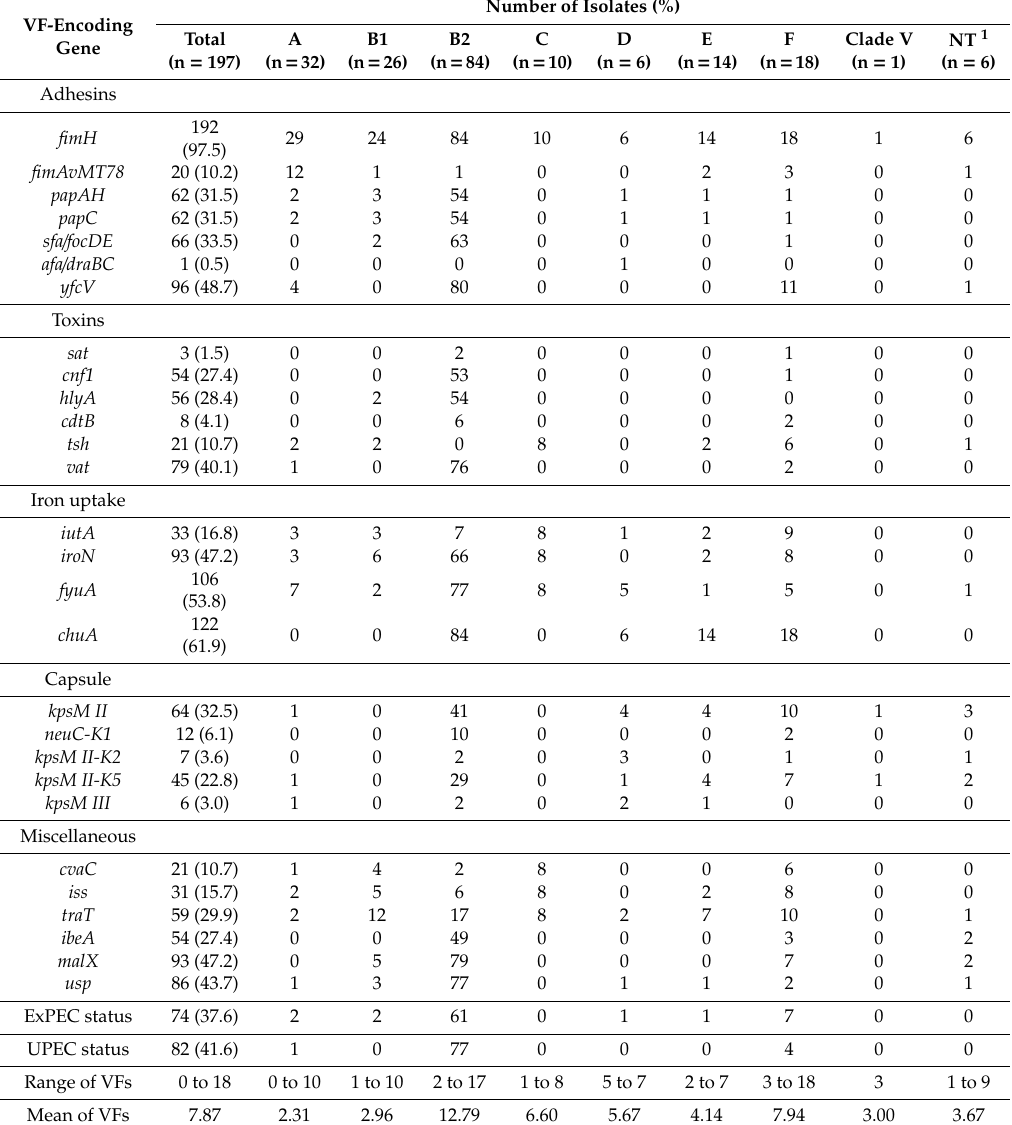
Table 1. Virulence factor (VF)-encoding genes detected in the 197 canine E. coli isolates. Relationship with phylogenetic